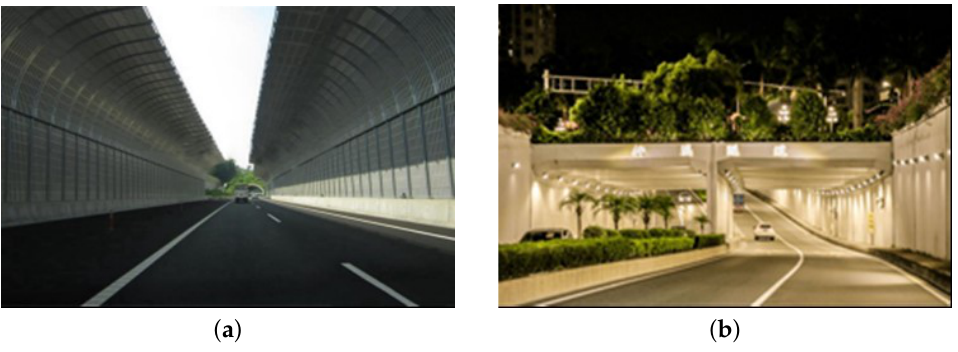
Figure 1. Various geometrical tunnels. ( a ) Rectangular tunnel. ( b ) Rectangular tunnel without